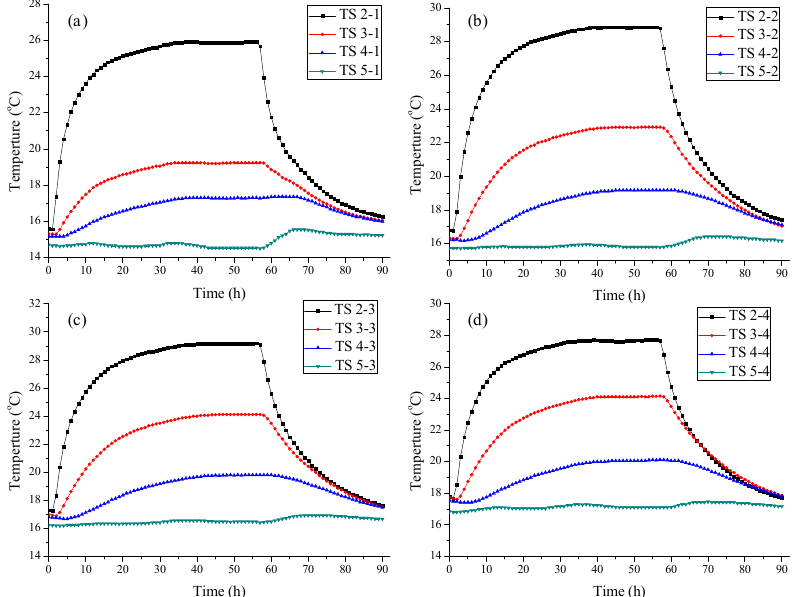
Figure 6. Time-dependent temperature curves of TSs of different distances to UT along each row in the fluid circulation of 50 °C: ( a ) No.1 TSs; ( b ) No.2 TSs; ( c ) No.3 TSs; ( d ) No.4 TSs.